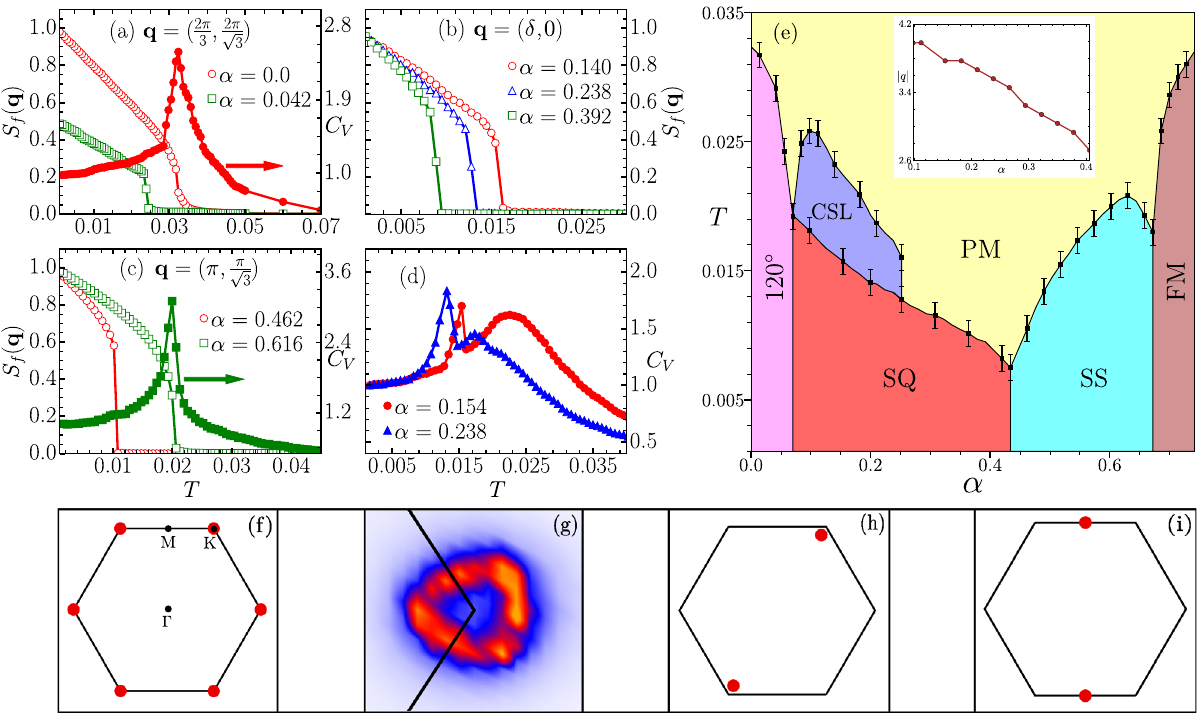
Figure 3. ( a )–( c ) Temperature dependence of spin structure factor (open symbols) at different values of q , and for different values of relative Rashba coupling strength α . The right y-axis in ( a ) and ( c ) is for specific heat (filled symbols) corresponding to one of the α values. ( d ) Specific heat as a function of temperature showing a broad hump followed by a sharp peak for two values of α . ( e ) Phase diagram obtained by tracking the features in the SSF and the specific heat with the different phases described as follows: the 120° denotes the well known three-sublattice order on triangular lattice. Single-Q (SQ) denotes a state where SSF displays peak only at a pair q of momentum. Spin stripe (SS) phase consists of ferromagnetic lines oriented antiferromagnetically w.r.t. ± neighboring lines. Classical spin liquid (CSL) denotes a phase with short-range correlations but no long-range ordering. ( f )–( i ) SSF plots for the four non-trivial phases displayed in the phase diagram. Note that the CSL state is characterized by a diffuse ring-like pattern centered at the K point. A zoomed in view is shown in panel ( g ). Inset in ( e ) shows variation in the magnitude q of the relevant wave-vector q with α for SQ